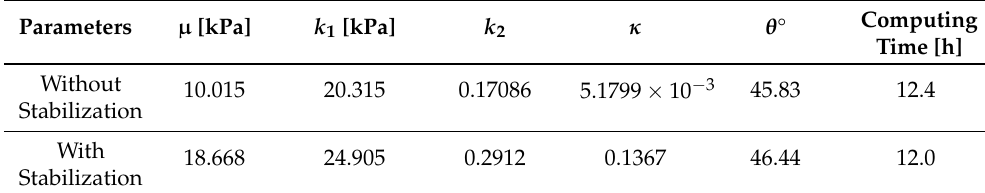
Table 6. GHO model parameters obtained with and without stabilization term. Parameters